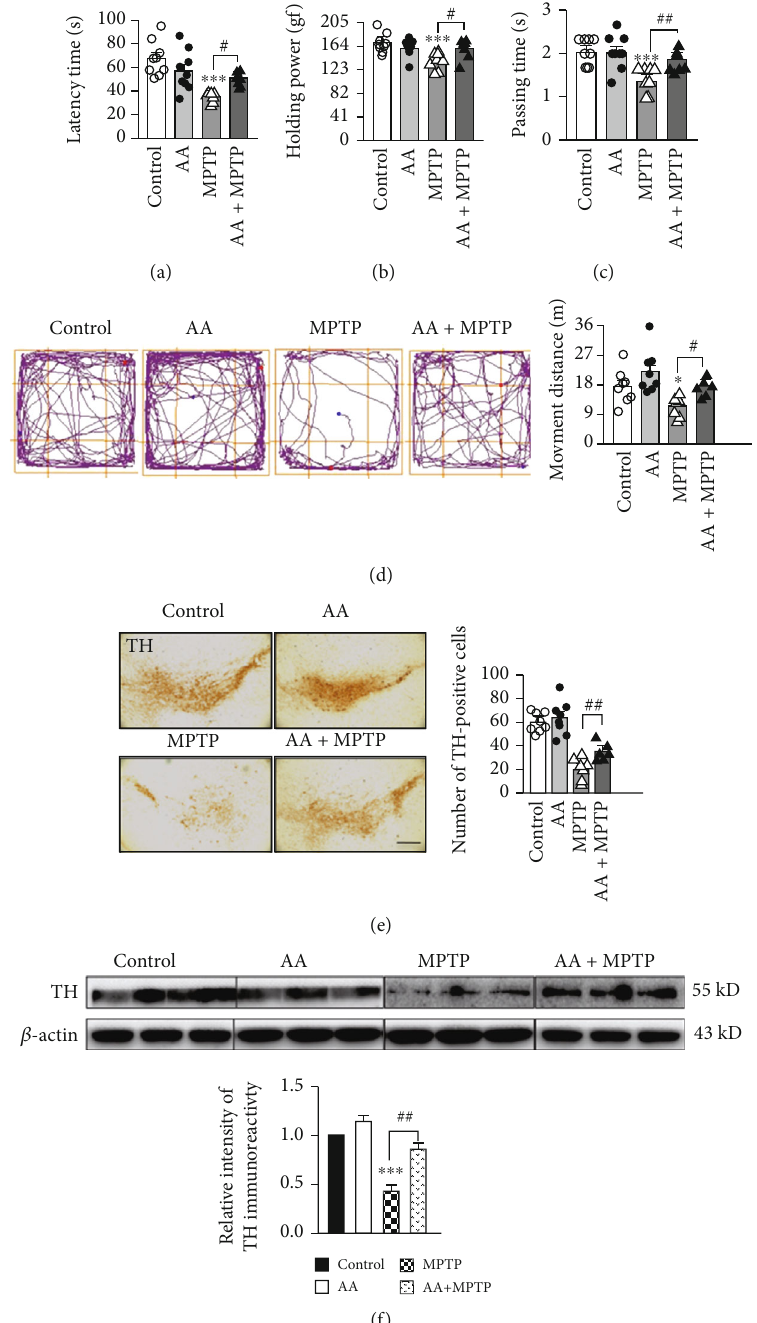
Figure 7: Ascorbic acid pretreatment ameliorates PD-like behavioral de fi cits and pathophysiology in an MPTP-induced mouse model of PD. (a) Holding times in the rotarod test were recorded after training mice for three days ( n = 6 ). (b) Grasping strengths were measured using a grip meter after training mice for three days ( n = 6 ). (c) Pole-climbing times were recorded after training mice for three days ( n = 6 ). (d) Motion tracking was monitor in the open- fi eld test ( n = 6 ). (e) The expression of TH in the midbrain was detected by immunohistochemistry (scale bar, 50 μ m) ( n = 3 ). (f) The expression level of TH in the midbrain was detected by Western blotting ( n = 3 ). Data were obtained from three independent experiments. One-way ANOVAs followed by LSD pairwise comparisons were performed. ∗ was considered signi fi cant compared to control ( ∗ P < 0 : 05 , ∗∗ P < 0 : 01 , and ∗∗∗ P < 0 : 001 ). # was considered signi fi cant compared to MPTP or MPP + ( # P < 0 : 05 , ## P < 0 : 01 , and ### P < 0 : 001